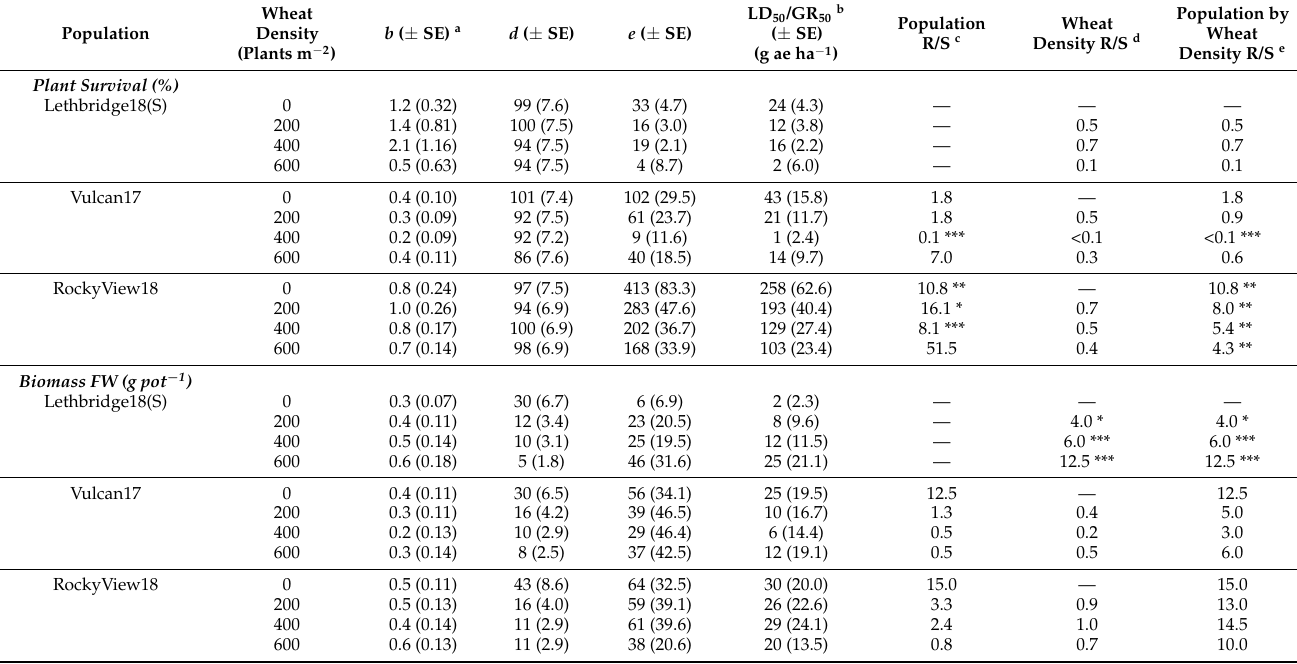
Table 1. Parameter estimates for the three-parameter Weibull type 1 models used to describe plant survival and shoot biomass fresh weight (FW) for three kochia populations in response to fluroxypyr rate in four wheat plant density treatments.